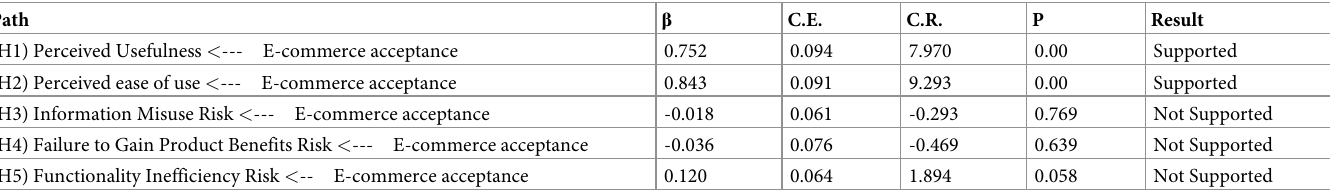
Table 4. Results of hypothesis